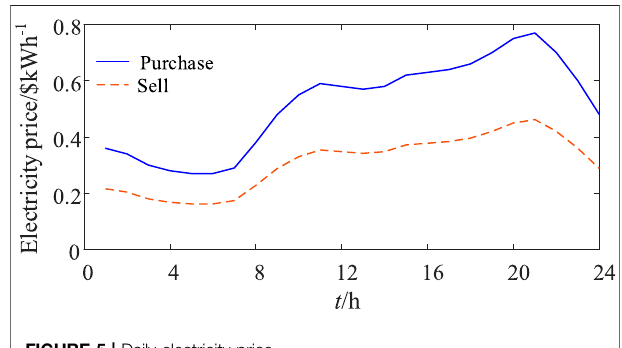
FIGURE 5 | Daily electricity price.